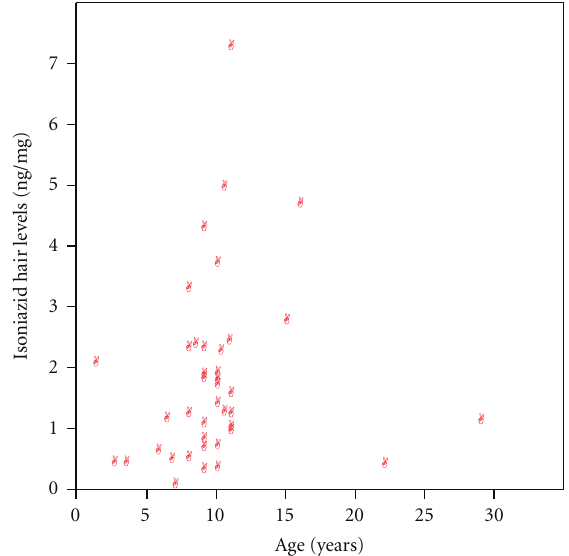
Figure 3: Correlation of isoniazid concentration in hair and